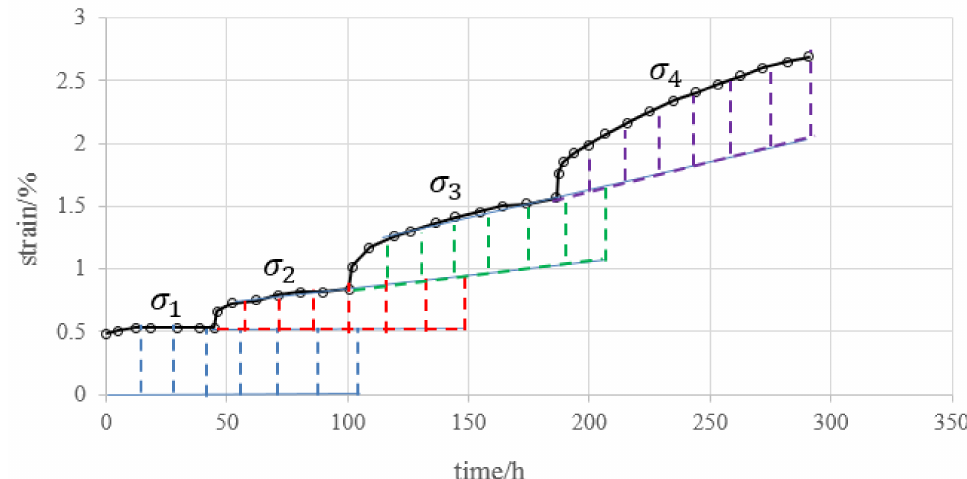
Figure 15. Creep strain decomposition of specimen under multi-step loading.